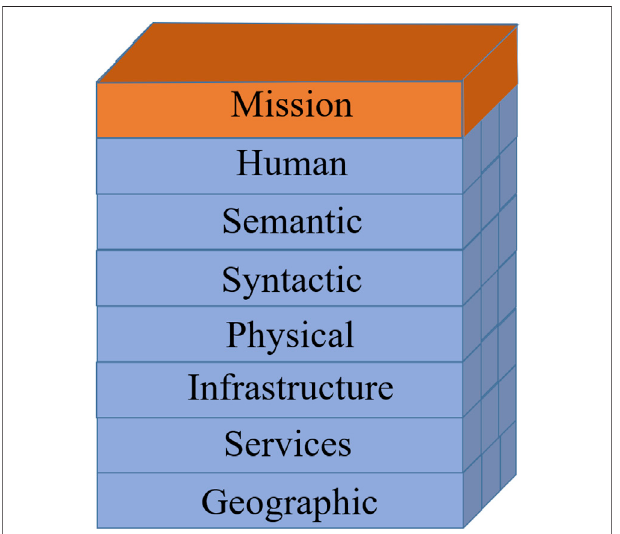
FIGURE 1 | The eight-layer model of